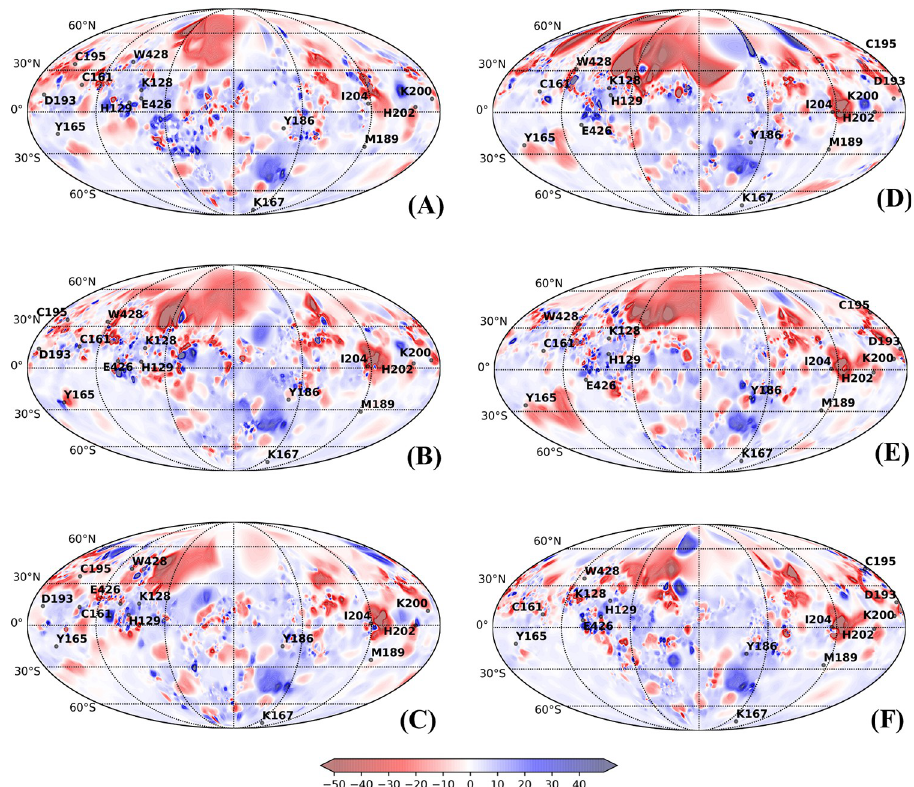
Fig 6. Protein surface topography representing molecular electrostatic potentials (MEP) localized to the CRD region with fourteen key residues were mapped onto 2D spherical projections for visual comparison of free and bound forms of Calnexin in Canis lupus (CNXC): (A) Free_Clus1; (B) Free_Clus2; (C) Free_Clus3; (D) Complex_Clus1; (E) Complex_Clus2; and (F)